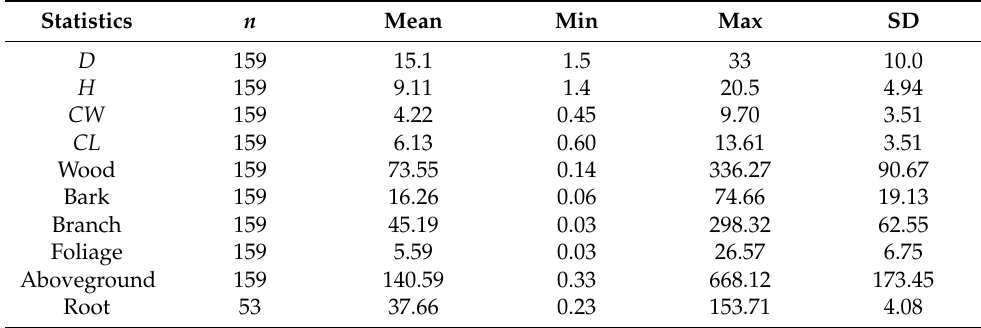
Table 1. Summary statistics of D (cm), H (m), CW (m), CL (m), stem wood, bark, branch, foliage, aboveground and root biomass (kg) for the sampled oak